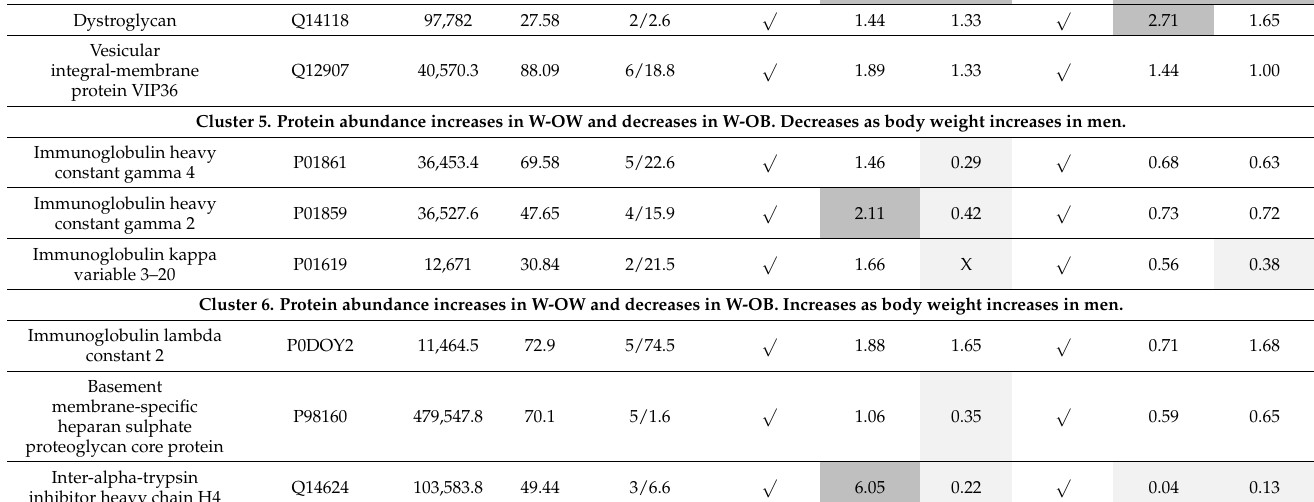
Cluster 2. Protein abundance decreases as the body weight